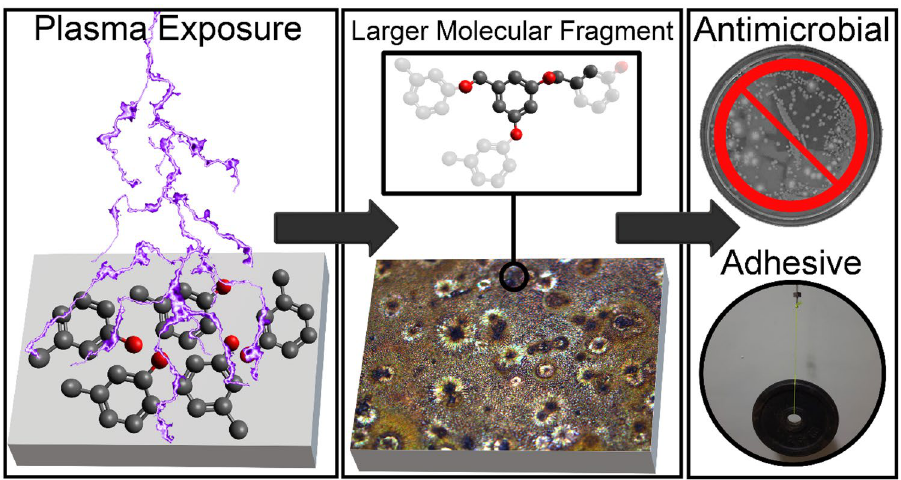
Figure 1. The concept of the polymerisation of m-cresol by plasma exposure on a substrate, creating coatings with antimicrobial properties and notable tensile bond strength as an adhesive, gluing substrates